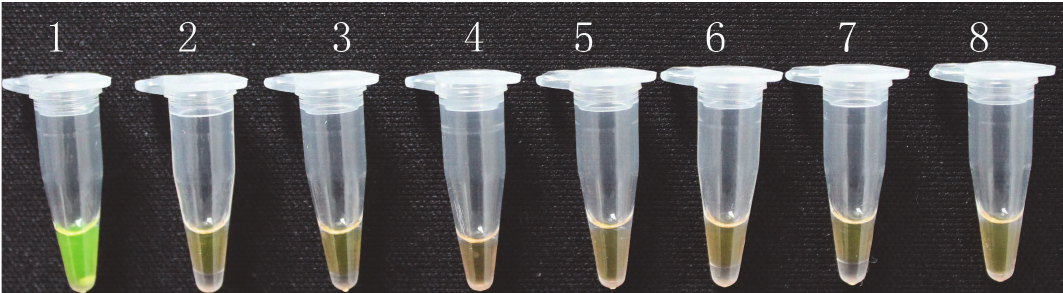
Figure 3: Specificity of LAMP assay. Tubes: 1, raccoon dog; 2, cattle; 3, deer; 4, dog; 5, horse; 6, pig; 7, sheep; 8, rabbit. The color of raccoon dog samples turned green, whereas the color of the others was still